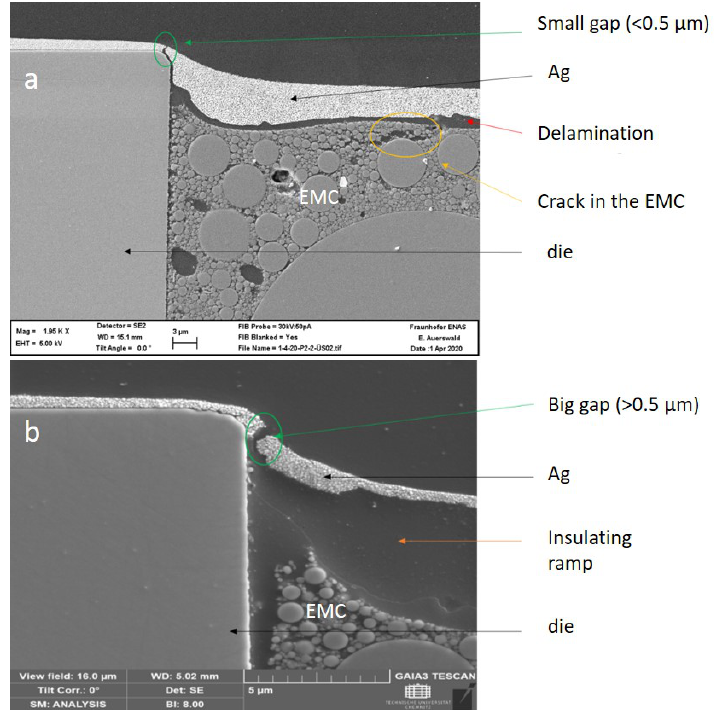
Figure 11. Cross-sectional scanning electron microscopy (SEM) images of the broken Ag tracks at the interface of EMC / die after thermal cycling manifesting the hotspots of the interconnects; ( a ) the sample with double-layered Ag line ( b ) the sample with double-layered Ag line and insulating ramp.